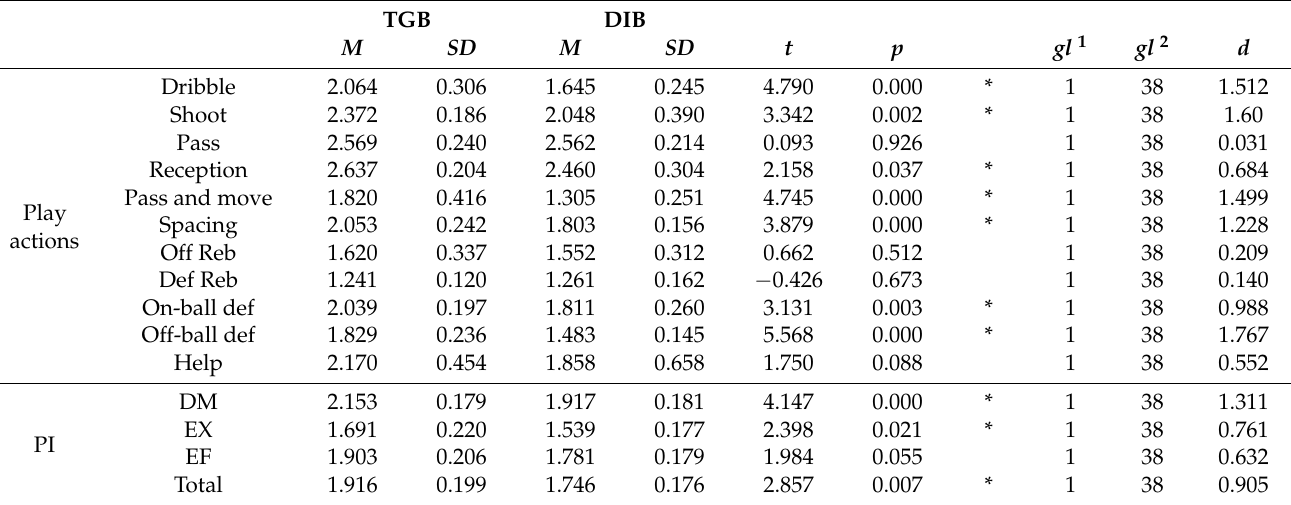
Figure 2. Characteristics of the students after the post-test. * p < 0.05. Table 3. Differences in performance between the students in the DIB and TGB units in the